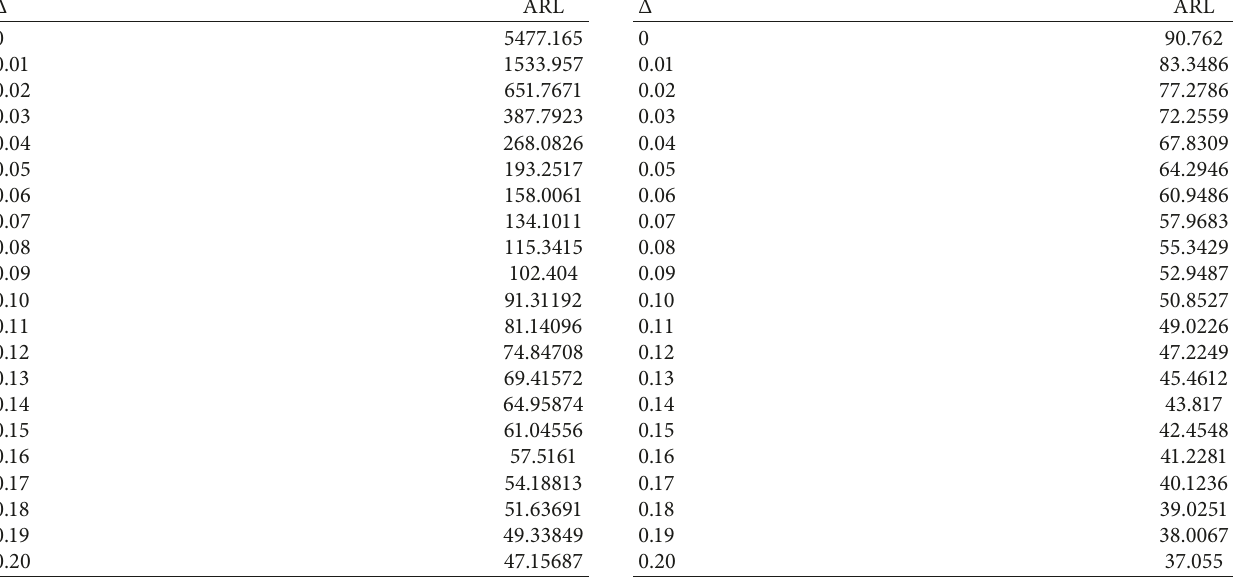
Table 7: Impact of estimation error for R